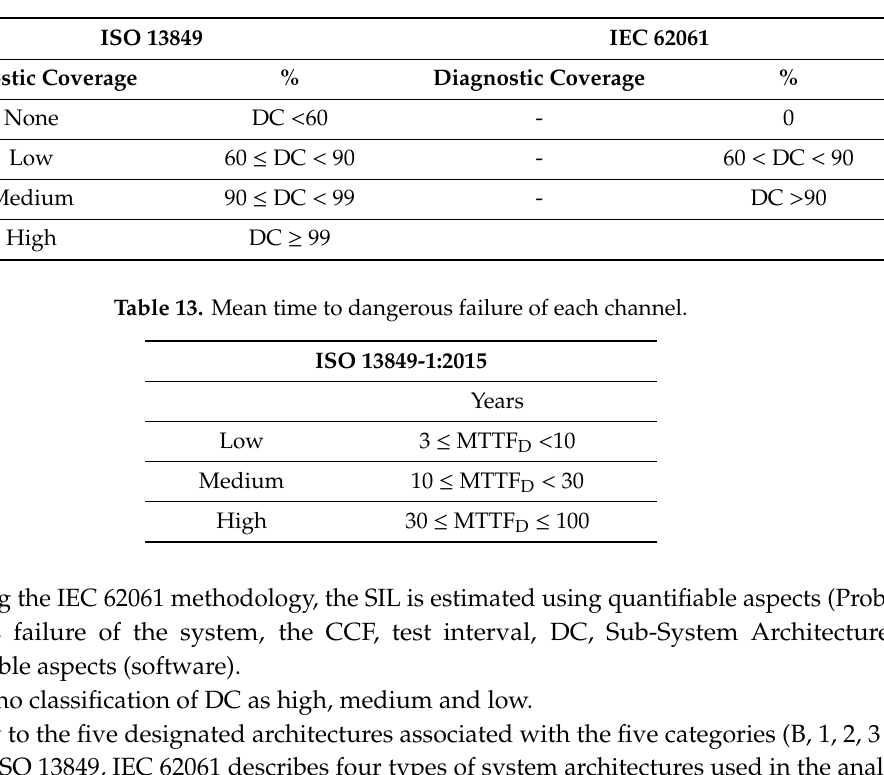
Table 12. Diagnostic coverage as defined in the two standards.